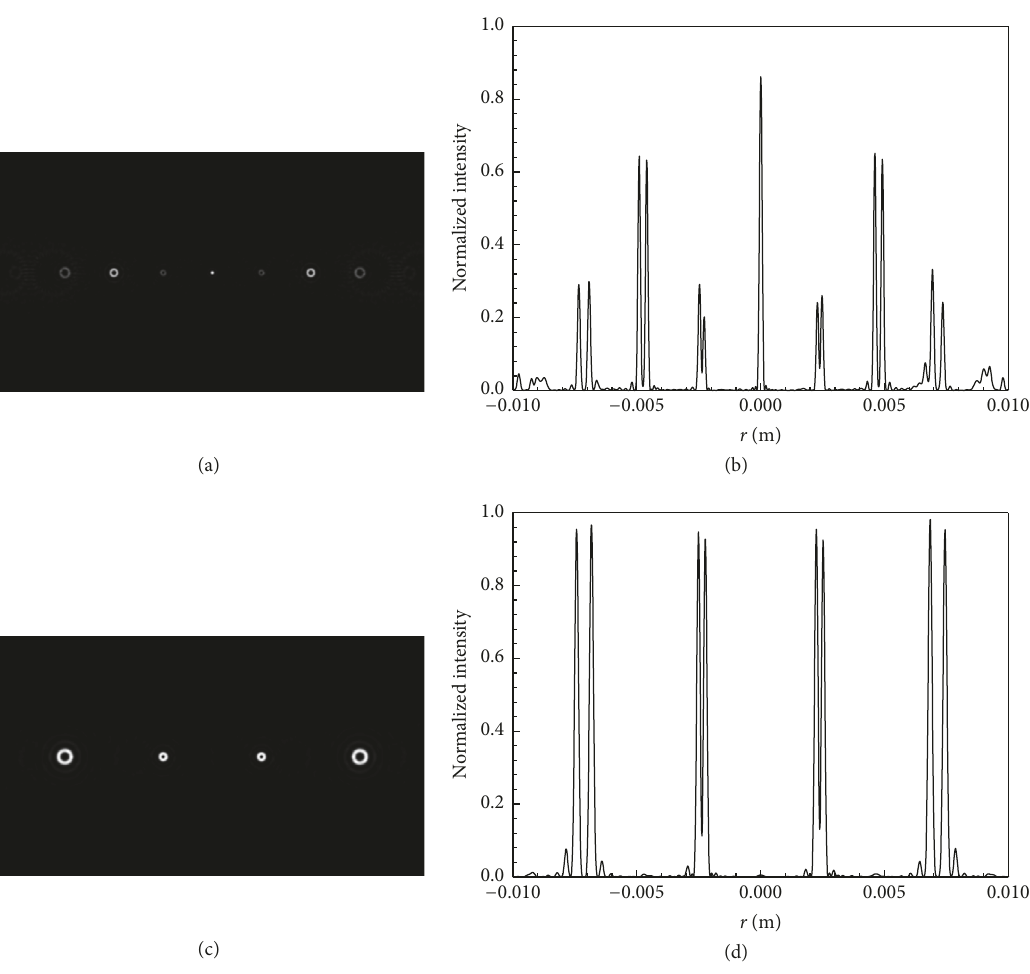
Figure2:Theemergentlightintensitydistributionandnormalizedspectrumdiagram.(a)ThelightintensitydistributionoftheoriginalDVG. (b) The corresponding normalized spectrum diagram. (c) The light intensity distribution of the EDVG. (d) The corresponding normalized spectrum